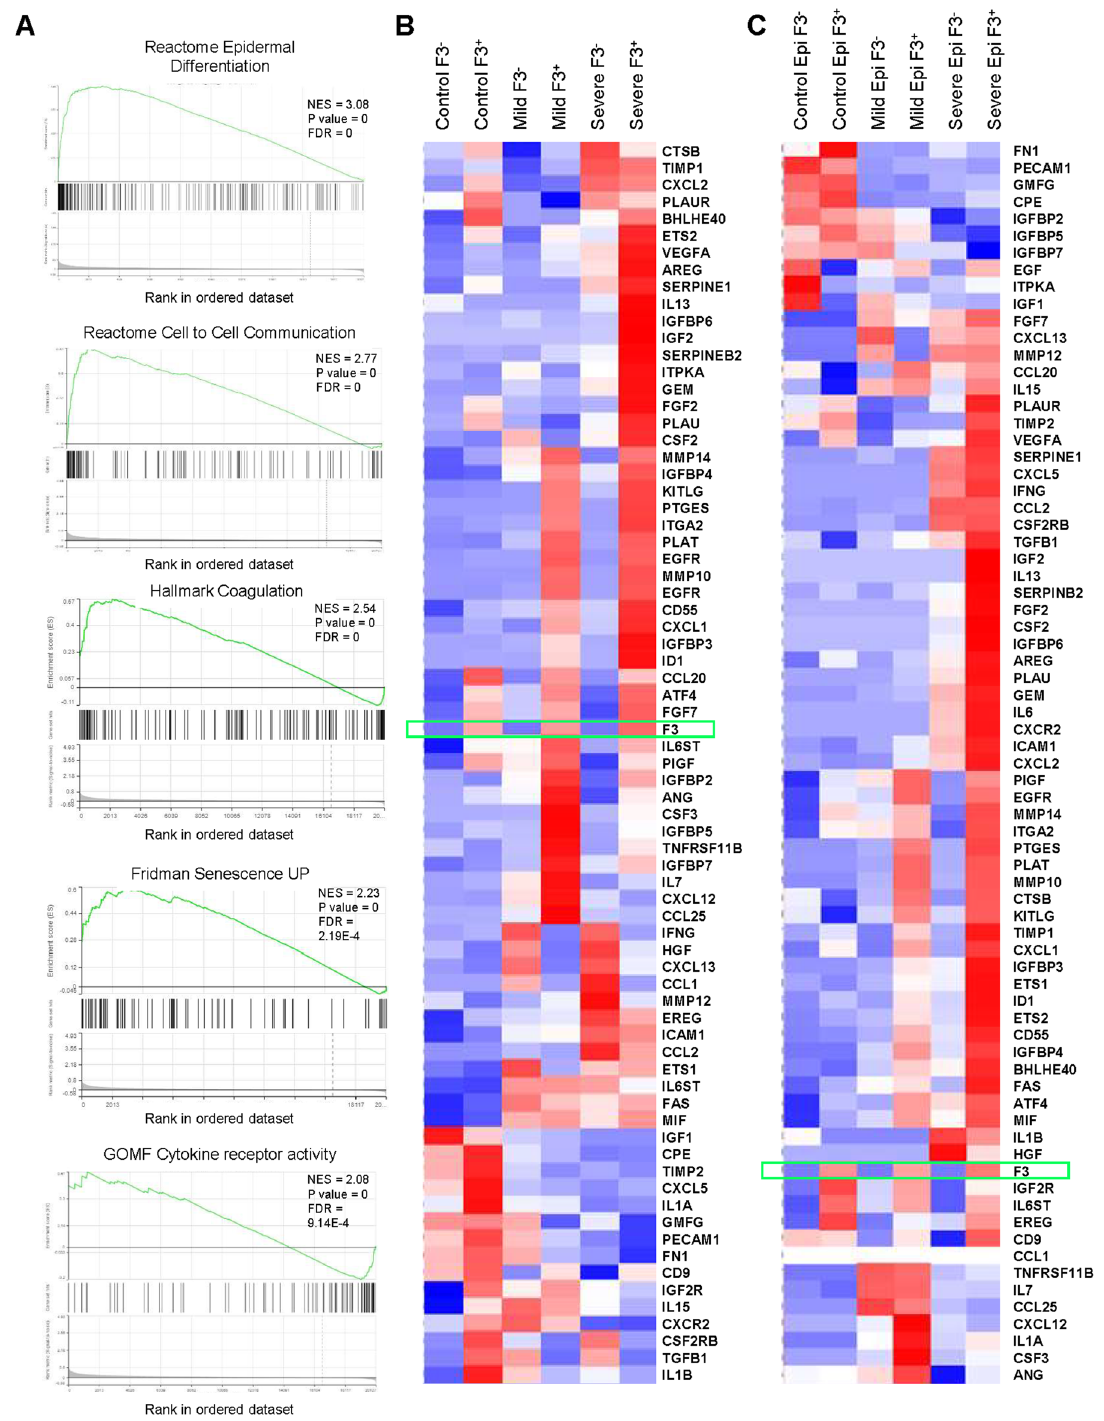
Figure 3. F3 + cell populations from COVID patients harbor the upregulated gene signatures for the senescence and coagulation pathways. ( A ) representative GSEA plots for reactome epidermal differentiation, senescence, and coagulation pathways in the F3 + populations from COVID patients 18 . ( B ) Heat map plot of the SASP factor expression in the F3 + and F3 − populations from BALF cells (Severe F3 + : 2100, Severe F3 − : 39,223, Mild F3 + :